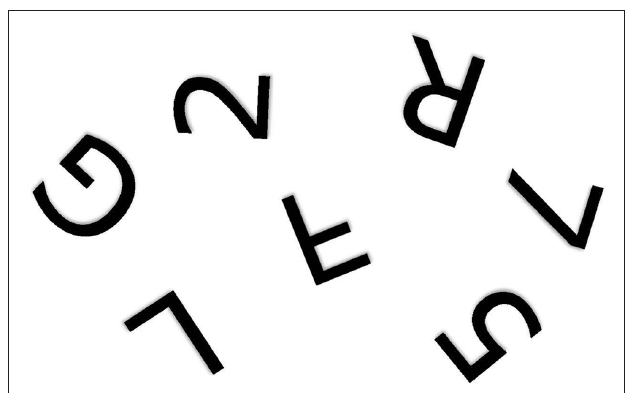
FIGURE 1 | One of the alphanumeric characters shown above is a mirror image of the true character. Which one? (Author’s drawing).